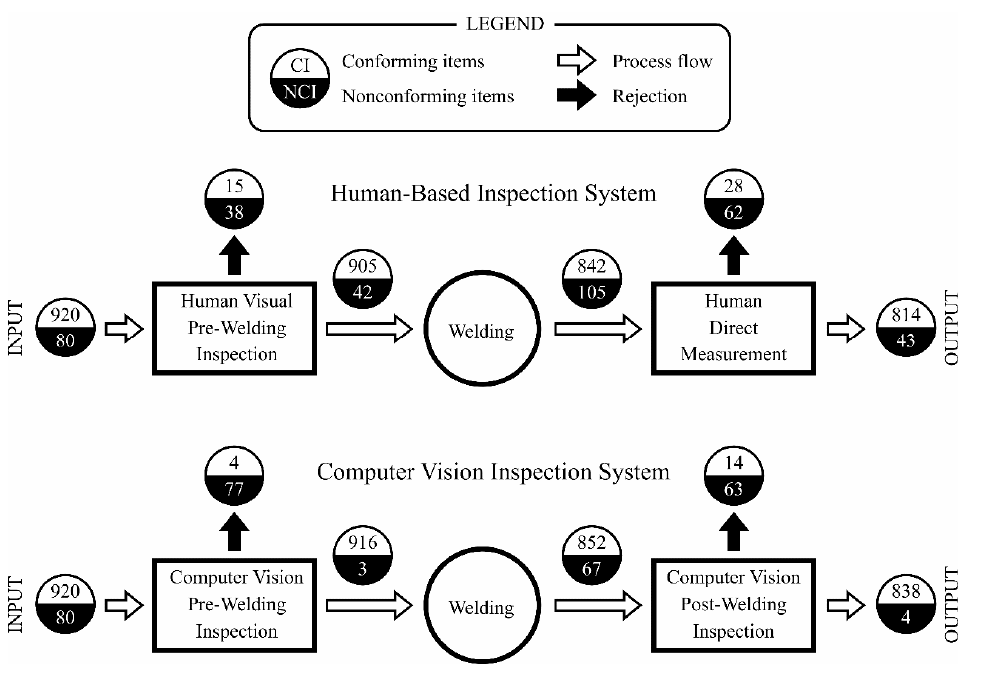
Figure 10. Practical validation results of the proposed system vs. human-based inspection.